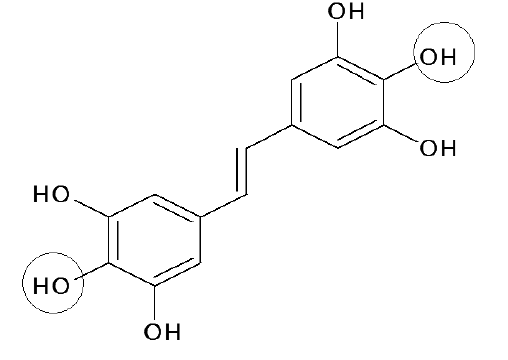
Figure 1. The chemical structure of stilbene M8 (3,3',4,4',5,5'-hexahydroxy- trans -stilbene). Additional hydroxy (–OH) groups in the highly reactive position ortho are marked in the circles. The role of the ortho hydroxyl groups in the augmentation of some biological properties of resveratrol (RVT) derivatives has been explained in the discussion